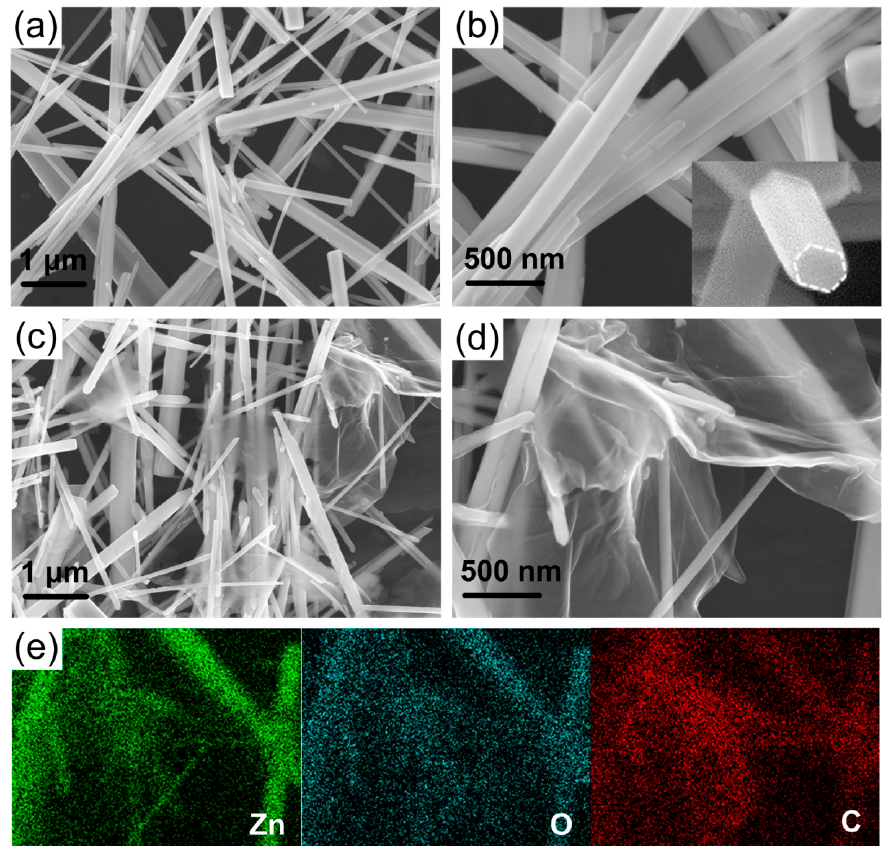
Figure 1. ( a ) Top-view and ( b ) partial enlarged field emission scanning electron microscopy (FESEM) images of one-dimensional (1D) ZnO nanowires (ZNWs), and the inset is the high magnification image of ZNWs; ( c ) Top-view and ( d ) partial enlarged FESEM images of reduced graphene oxide/ZNWs (RGO/ZNWs) composites with 1.0 wt % of RGO loaded; ( e ) Corresponding energy disperse spectrum (EDS) mappings of Zn, O, and C in RGO/ZNWs composites with 1.0 wt % of RGO loaded.